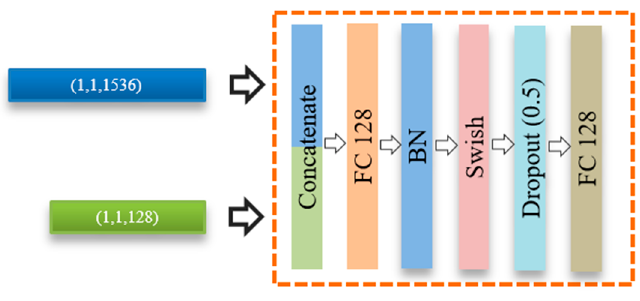
Figure 7. Structure of the fusion module.